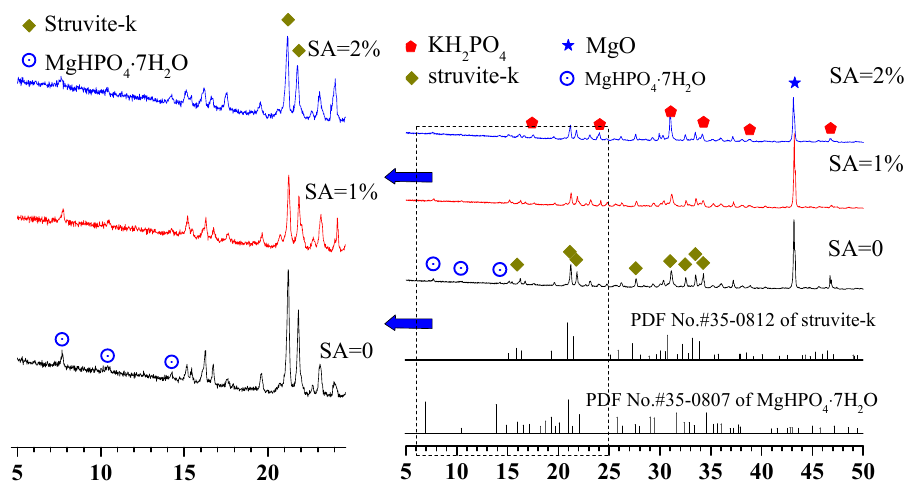
consistent with the mechanical results of MKPCs at a w/c ratio of 0.2 (Figure 3), where adding sodium alginate could lower the compressive strength of MKPC, and further ad- dition of sodium alginate resulted in a slight increase in compressive strength.